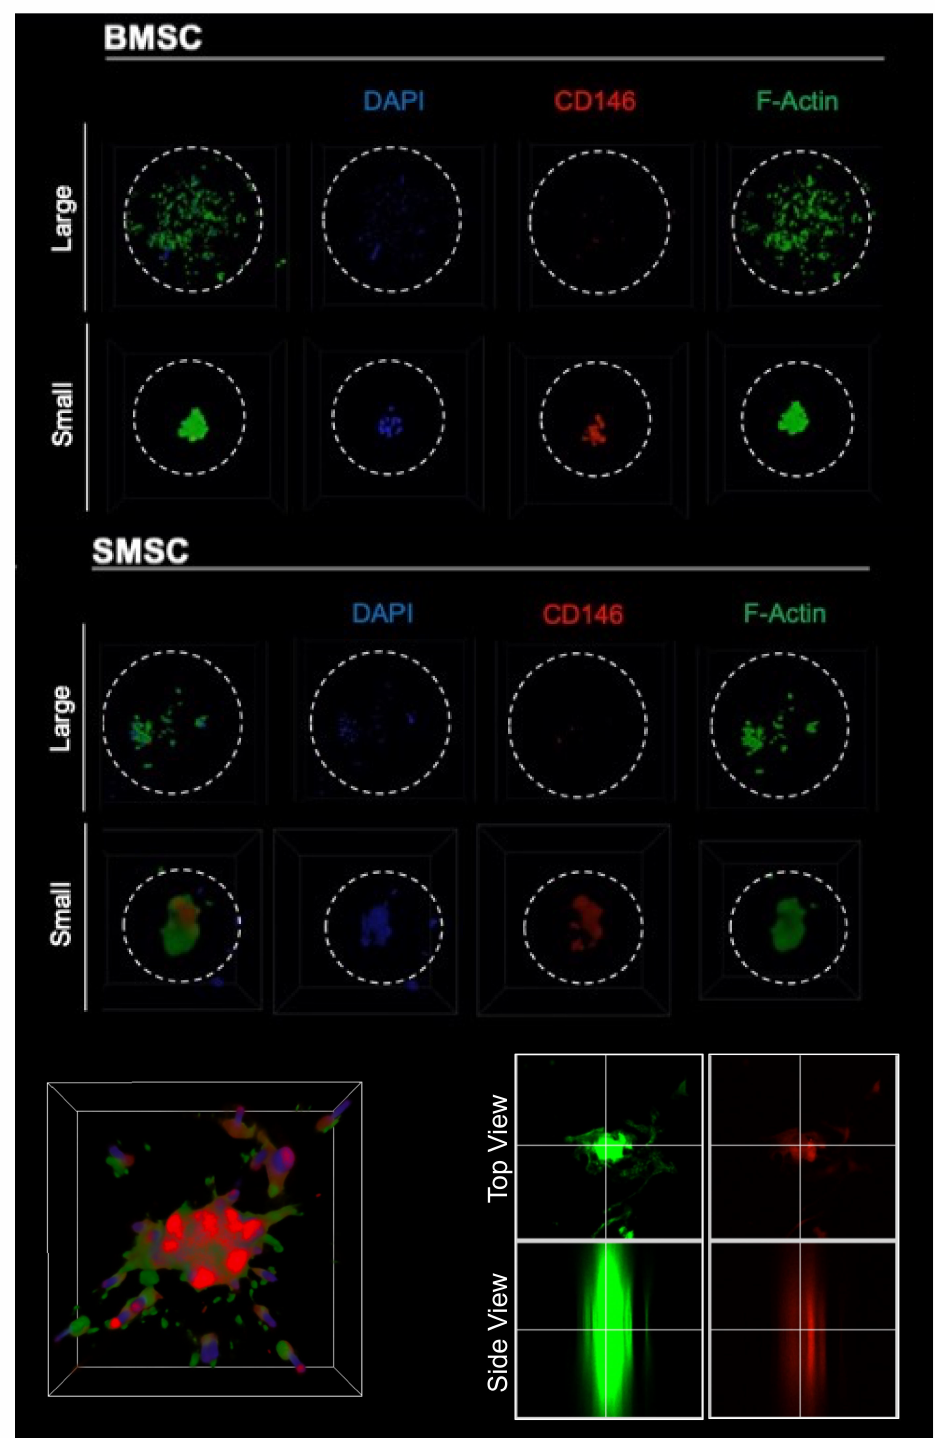
Figure 9. Concurrent with decreases in YAP phosphorylation in large pores at 48 h, CD146 expression is significantly decreased in large pores compared to small in both BMSC and SMSC. A cross section of CD146 immunofluorescence for BMSCs cultured in small pore constructs for 48 h is shown at the bottom. Circular dotted lines indicate macropore